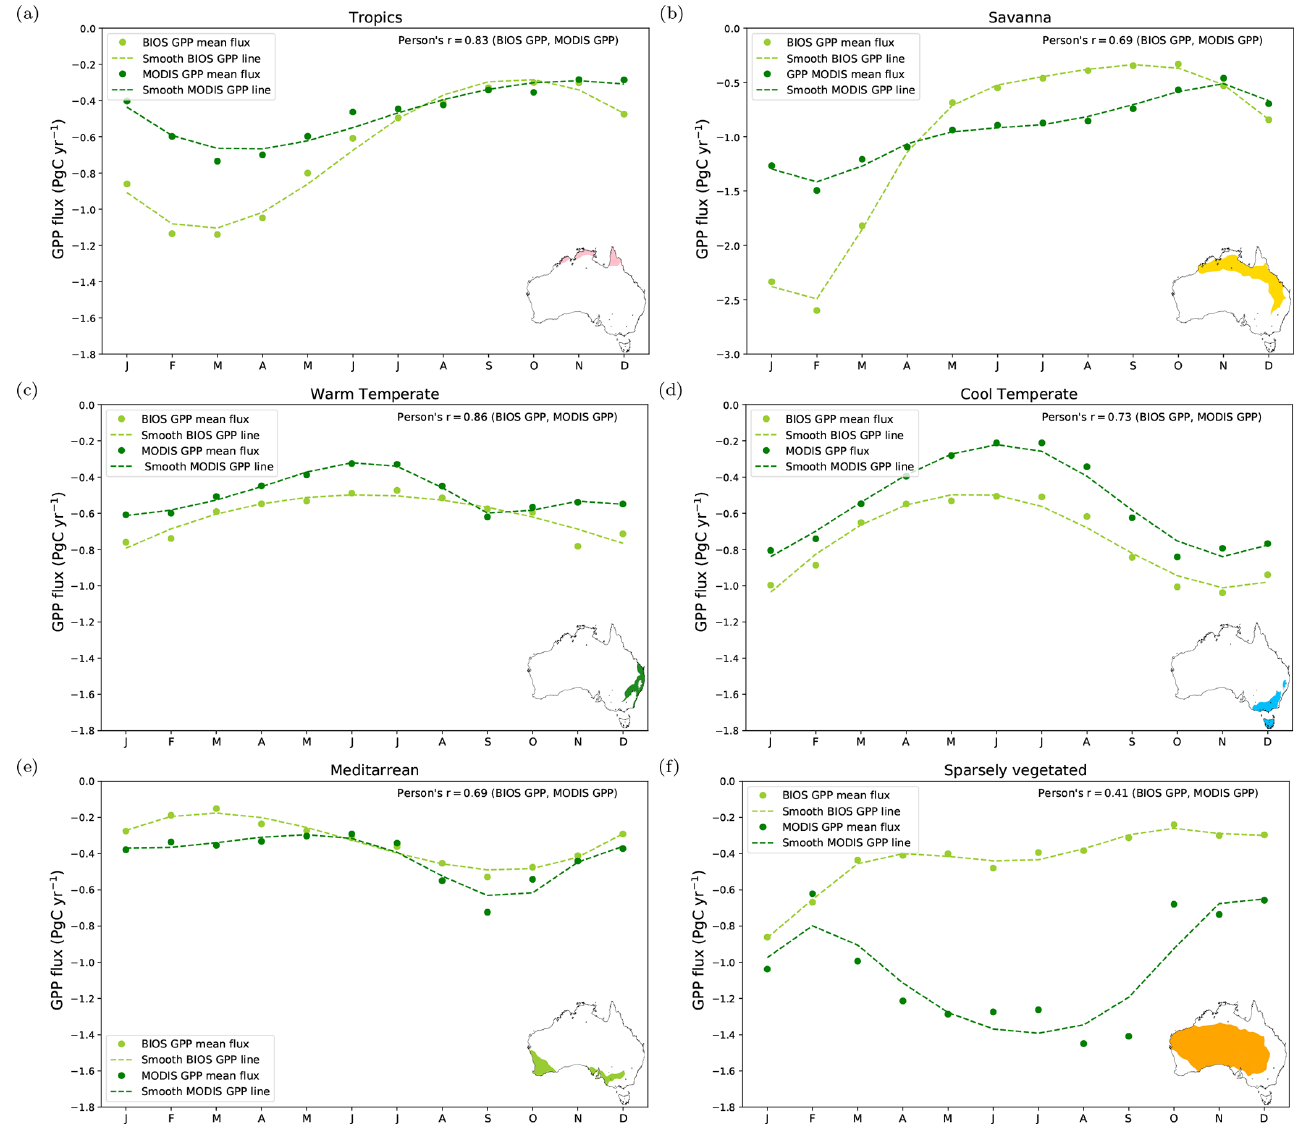
Figure E1. Time series of monthly mean of CABLE-BIOS3 GPP and MODIS GPP.